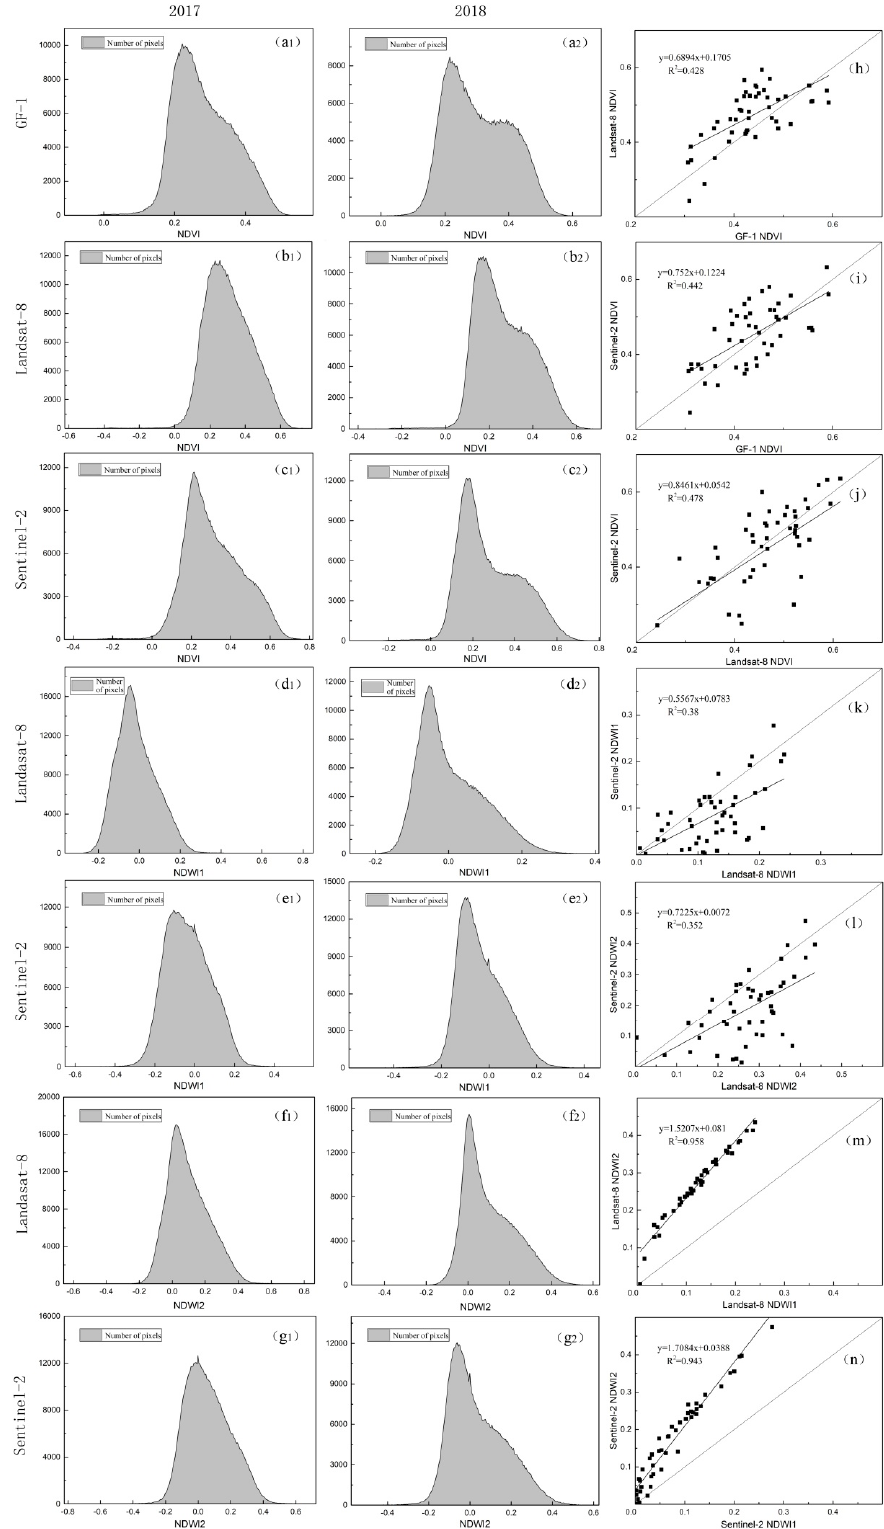
Figure 3. Pixel number distribution of each index data (left and middle) and relationship between di ff erent optical indices collected from 46 measured sites in two time periods (right) (2017 and 2018, represent the optical data used in this study in 2017 and the optical data used in 2018,